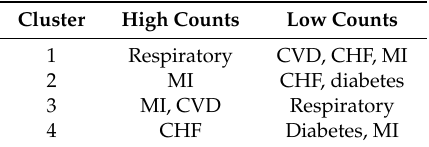
Table 1. High and low counts by cluster.